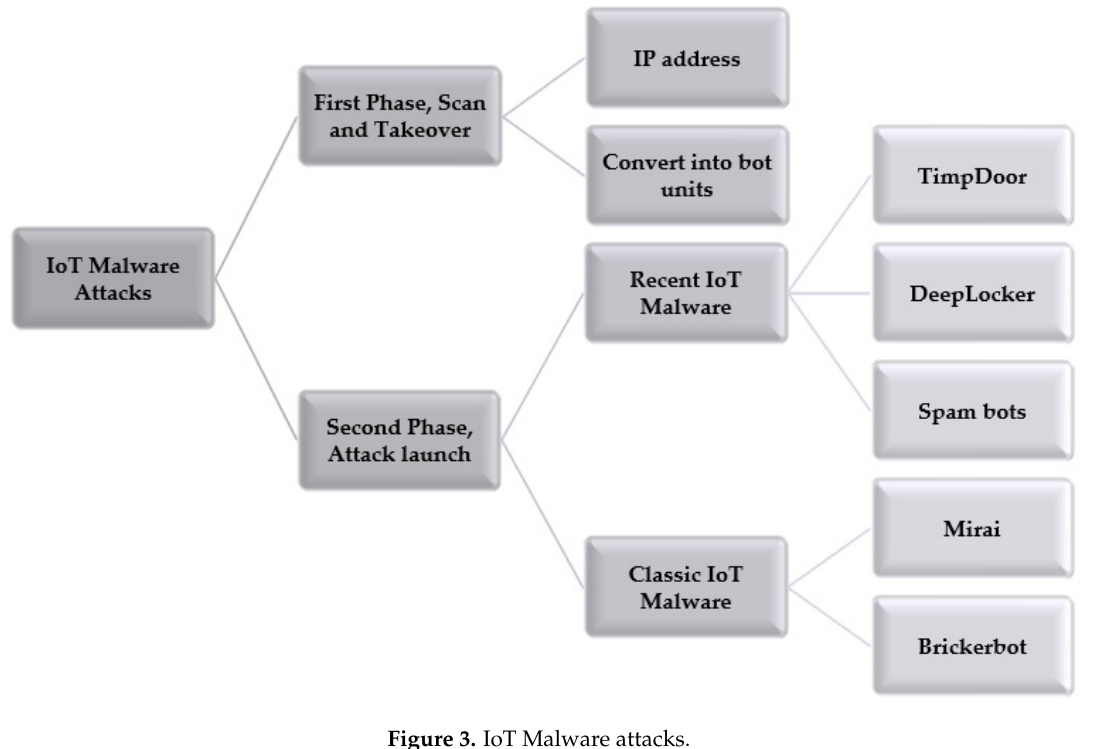
Figure 3. IoT Malware attacks.